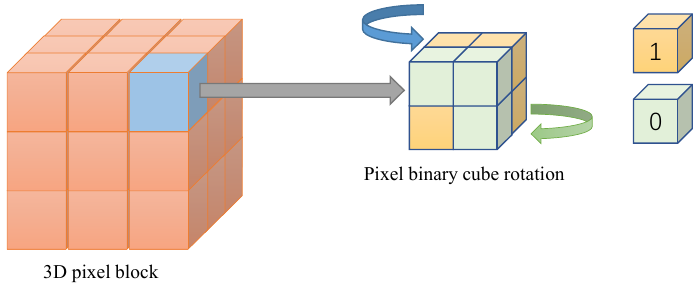
Figure 8. Binary cube rotation based on probability magnitude matrix.